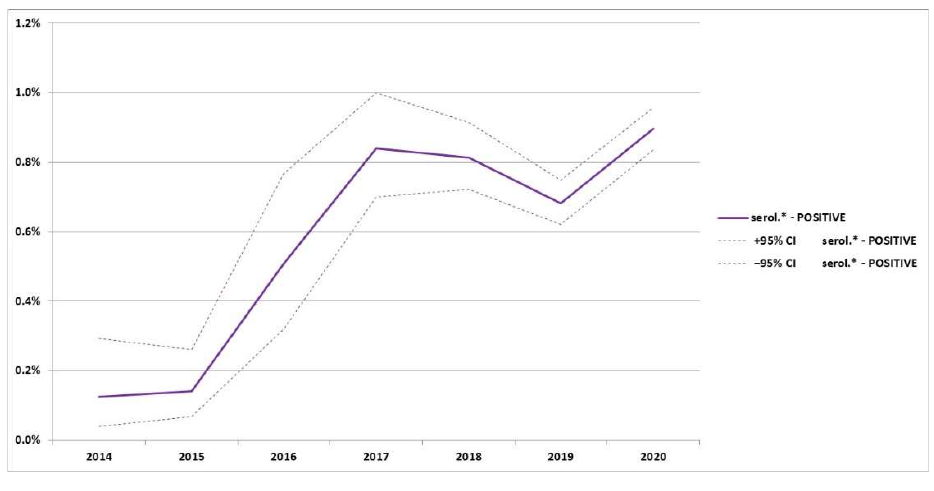
Figure 5. Percentage of ASF-positive wild boars in relation to wild boars analyzed with both types of tests in years 2014–2020.